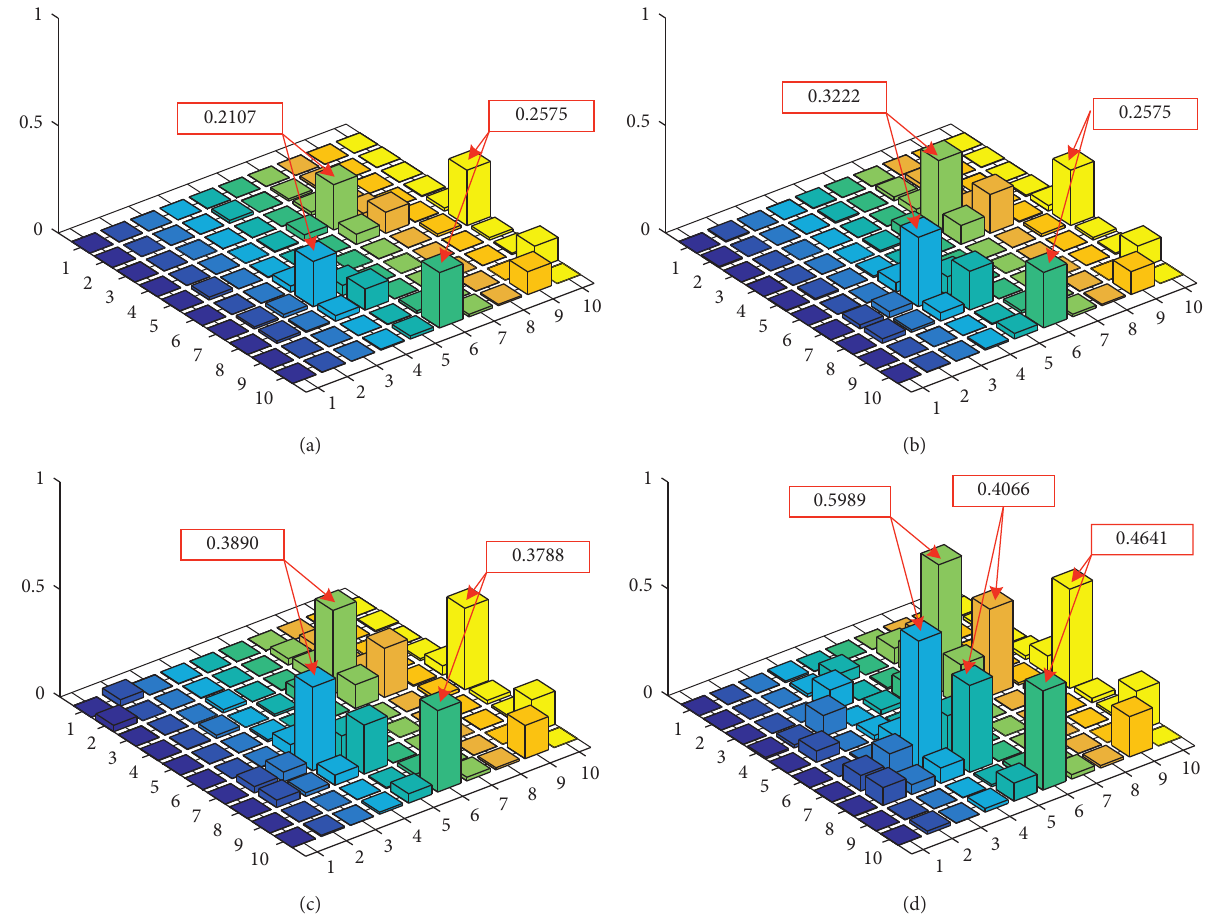
Figure 7: The MAC matrix corresponding to different sensor placement schemes. (a) 50 sensors. (b) 30 sensors. (c) 20 sensors. (d) 10